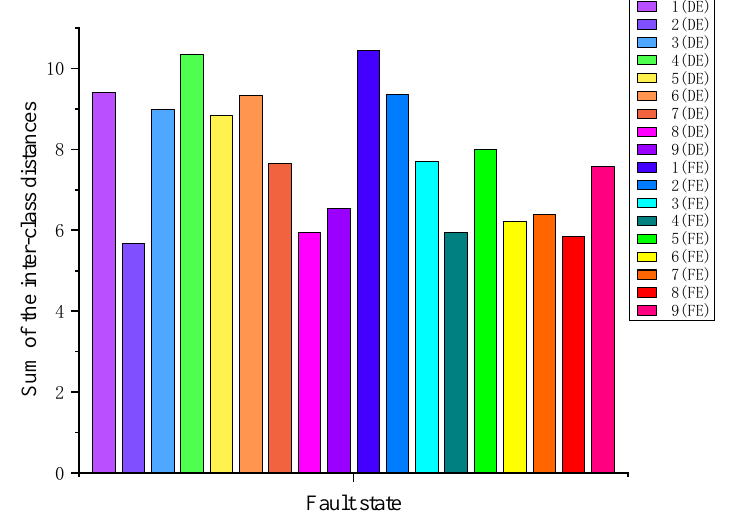
Figure 7. Sum of S b for each fault state.